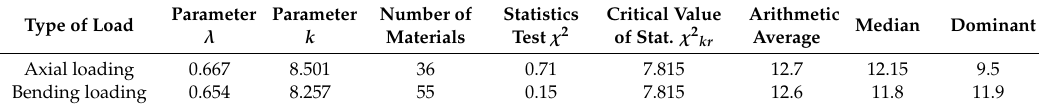
Table 4. Values of gamma distribution parameters for the coe ffi cient a